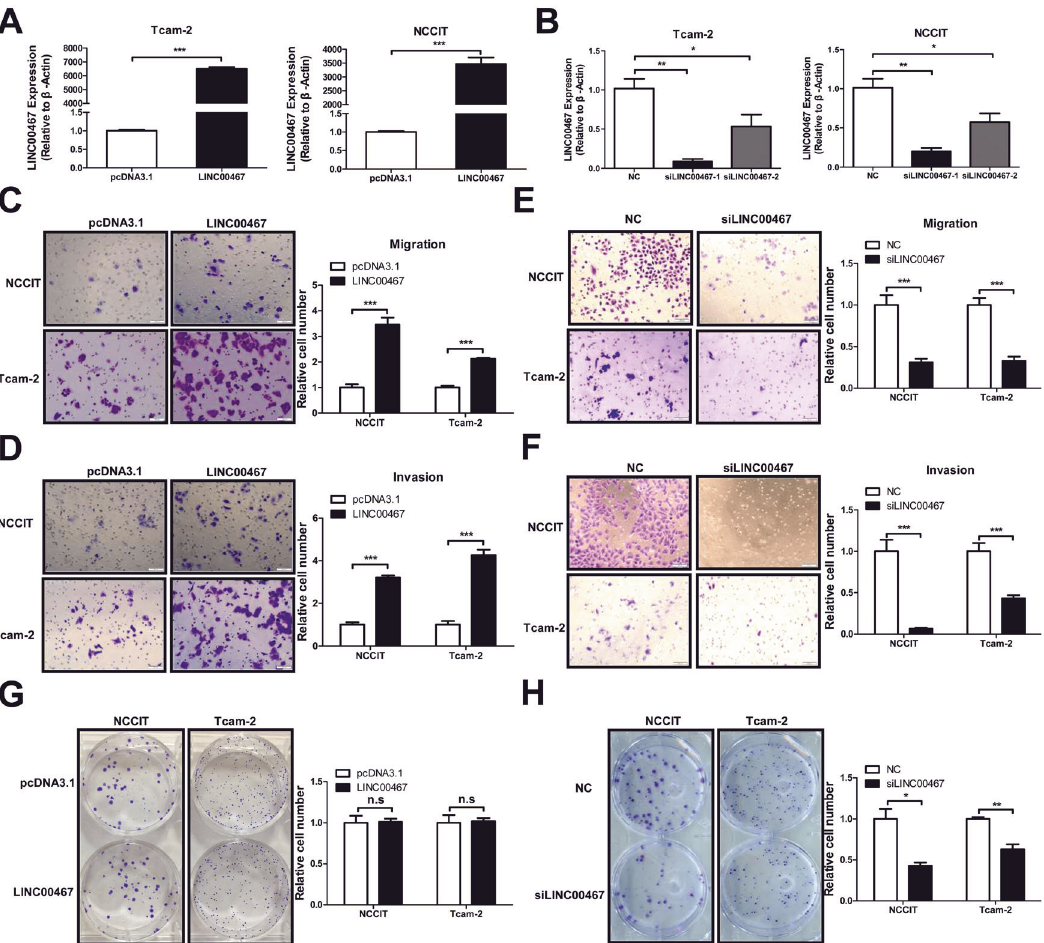
Fig. 5 LINC00467 promotes TGCT cell migration and invasion. A qRT-PCR assay was used to detect LINC00467 overexpression in the cell lines. B qRT-PCR assay was used to detect the silencing ef fi ciency of LINC00467 siRNA in the cell lines. The relative expression of LINC00467 in each group was calculated using β -actin as an internal reference and normalized to 1 in the NC siRNA group. C , E Transwell cell migration assays were used to determine the effects of LINC00467 overexpression ( C ) and the silencing of LNC00467 ( E ) on the migration ability of TGCT cells. D , F Transwell cell invasion assays were used to determine the effects of LINC00467 overexpression ( D ) and the silencing of LNC00467 ( F ) on the migration ability of TGCT cells. G , H Clone formation assay to detect the effect of LINC00467 overexpression ( G ) and the silencing of LNC00467 ( H ) on the colony-formation ability of TGCT cells. * P < 0.05; ** P < 0.01; *** P < 0.001; n.s. no signi fi cance. All experiments were performed in triplicate. Scale bar = 100 μ